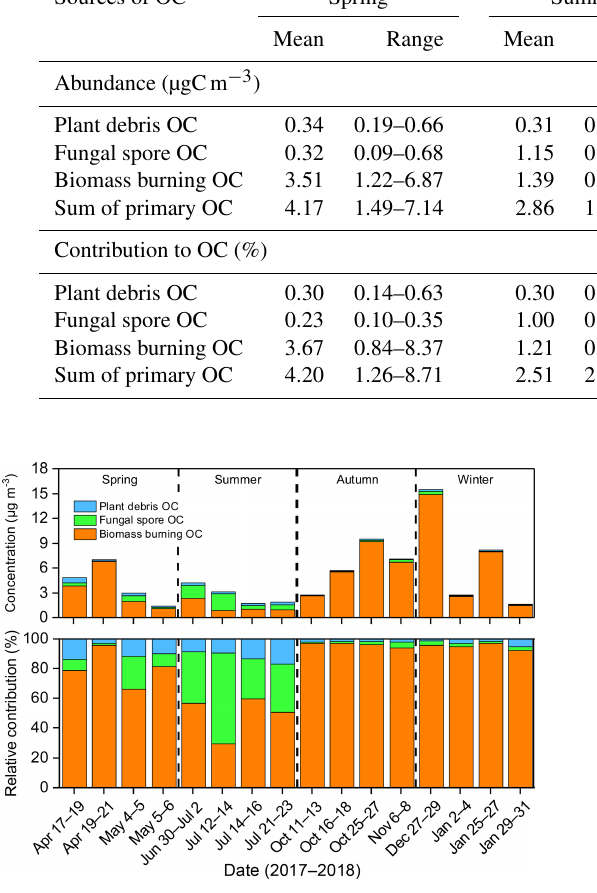
Figure 8. Monthly variations in plant-debris-derived OC, fungal- spore-derived OC, and BB-derived OC in urban aerosols in Beijing and relative contributions of these primary